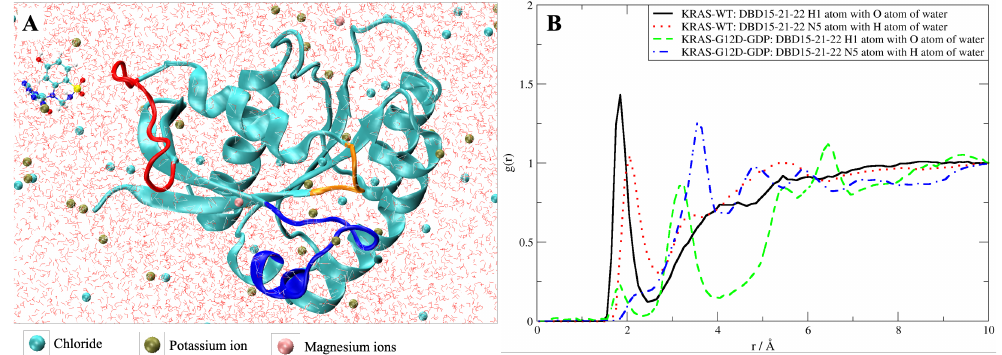
Figure A18. The distance between H1 and O3 atoms in DBD15-21-22.